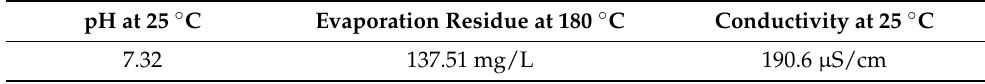
Table 2. Mineral chemical composition of the water